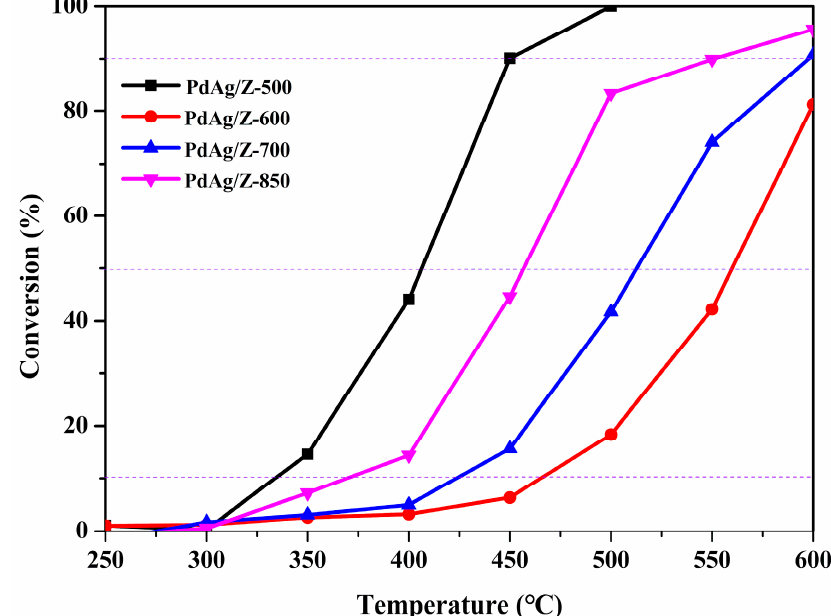
Figure 3. Methane conversion curve by PdAg/Z alloy catalysts calcined at different temperatures. The reaction conditions were: heating rate 10 °C min − 1 and flow rate of the reacting feedstock 40 ml min − 1 (2 vol % CH 4 /Ar and 4 vol % O 2 /Ar, space velocity 72000 h − 1 ).